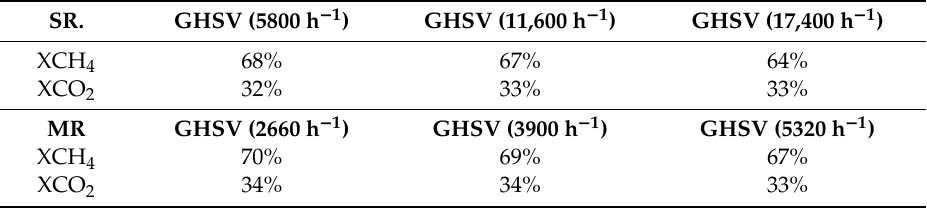
Figure 17. Overall methane conversion in RMM as function of HRF. Table 5. Methane conversion, carbon dioxide yield, and hydrogen recovery factor at fixed GHSV Table 6. E ff ect of GHSV in SR and MR.